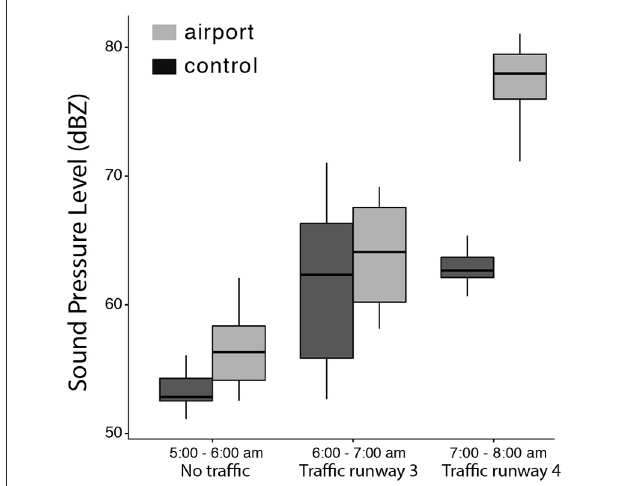
FIGURE 2 | Noise levels at both sites during early morning. Before 6 a.m. there are some small differences between sites that disappear at 6 am. However, obvious differences between study sites arise at 7 am with the onset of day-time traffic schedule.